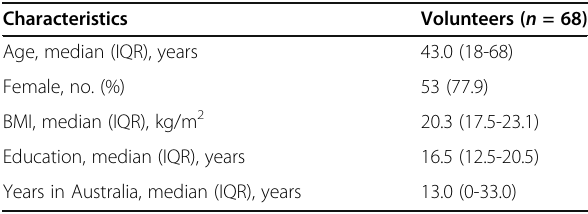
Table 1 Demographic data of Japanese-English